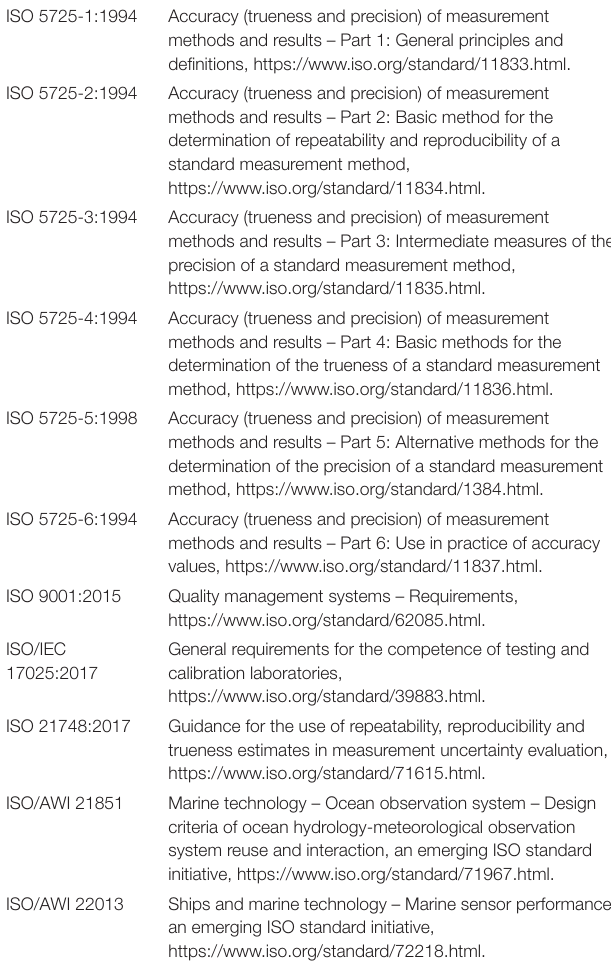
TABLE 4 | Overview of applicable ISO